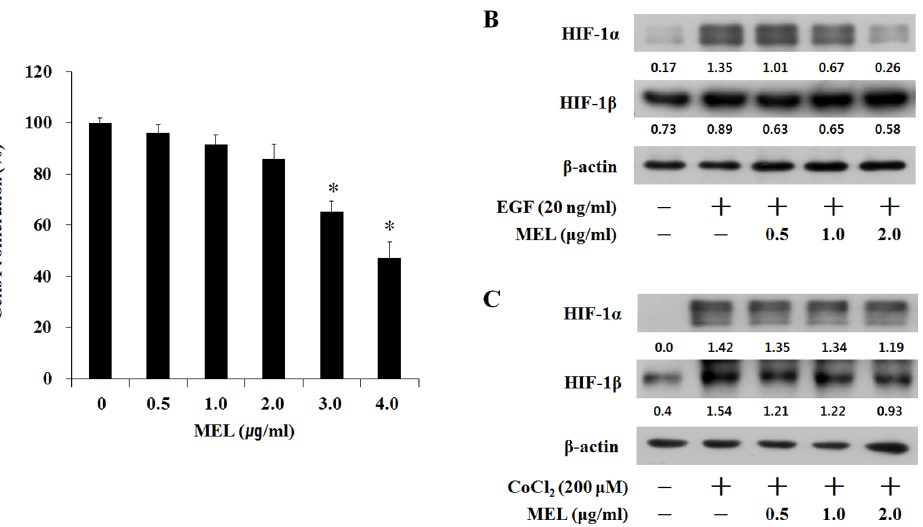
Figure 1. Melittin (MEL) inhibited the HIF-1 a protein accumulation induced by the EGF in the CaSki cells. (A) Dose-dependent effect of MEL on the viability of CaSki cells. Cells were treated with the indicated concentrations of MEL for 24 h. Viability was determined by WST-1 assay. Values represent the means 6 SD of triplicate assays. *, p , 0.05 as compared to untreated control. Results were analyzed using one-way ANOVA. (B) Cells were pretreated with the indicated concentrations of MEL for 30 min, and then induced by EGF treatment for 6 h. (C) Cells were pretreated with the indicated concentrations of MEL for 30 min, and then induced by CoCl 2 treatment for 6 h. Nuclear extracts were subjected to Western blot using antibodies against HIF-1 a and HIF-1 b .